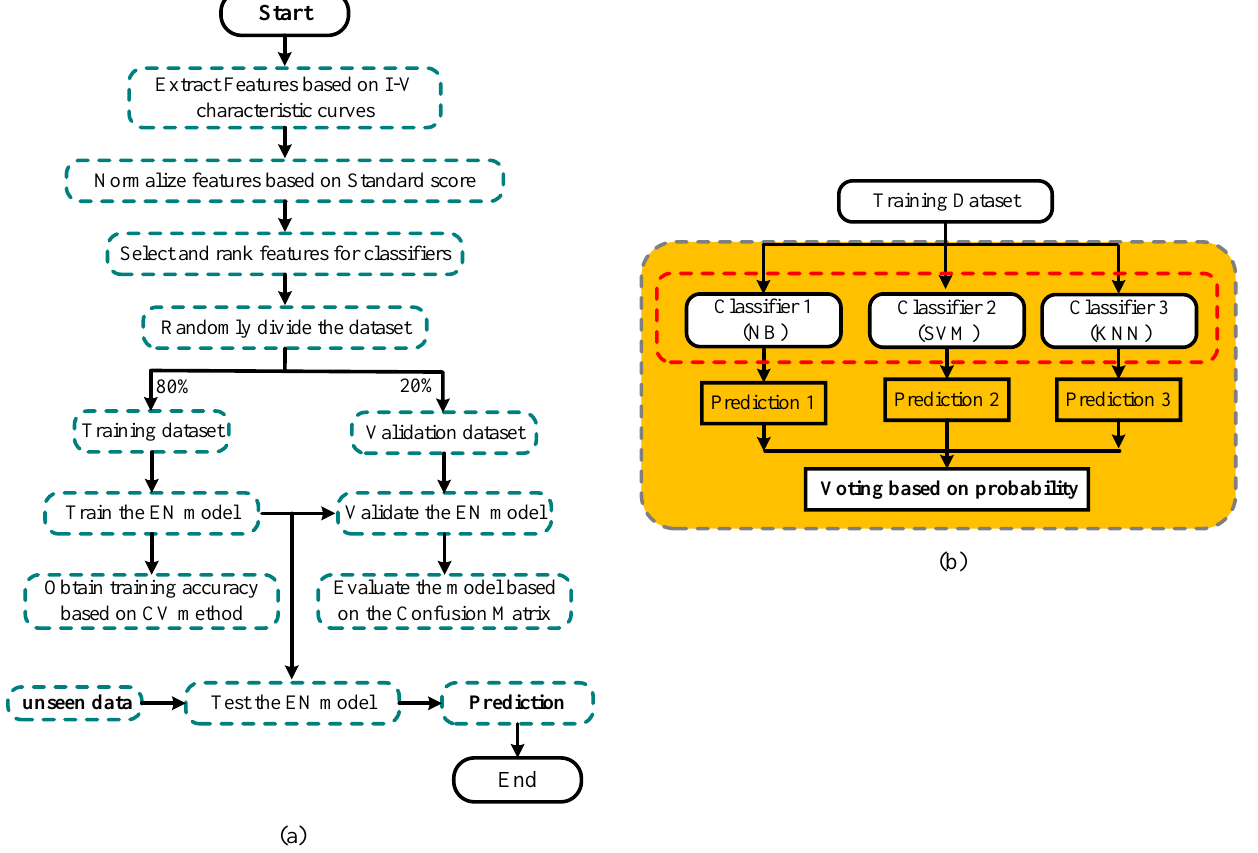
Figure 10. ( a ) The algorithm structure of the proposed method, and ( b ) flowchart of the EN model.